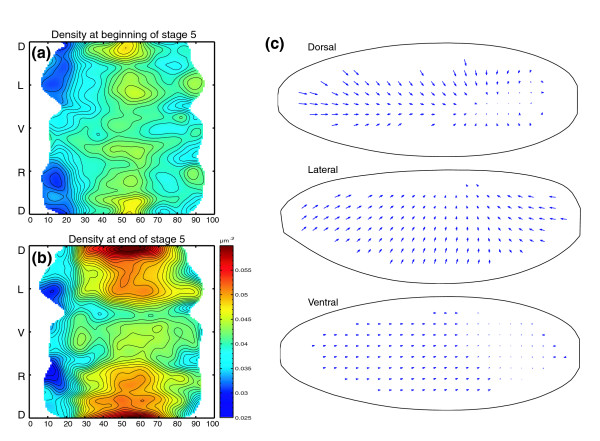
Nuclear density patterns and movements in living Histone2A-GFP embryos. (a,b) Cylindrical projections of average nuclear density maps derived from portions of 22 living embryos expressing Histone2A-GFP. Density maps for this set of embryos are shown at the start of stage 5 (a) and at the end of stage 5 (b). The axis and isodensity contours are labeled as in Figure 1. The density patterns seen are remarkably similar to those derived from fixed material (Figure 1). (c) Orthographic projections of the average distance and direction of nuclear movement in two dimensions for n = 1 embryo in the dorsal orientation, n = 8 embryos in the lateral orientation, and n = 4 embryos in the ventral orientation. These arrows represent a local average movement within each embryo calculated from time-lapse series as well as an averaging over the various embryos in similar orientations. As expected from the changes in nuclear densities, a net flow of nuclei from the poles towards the mid-dorsal region was observed.